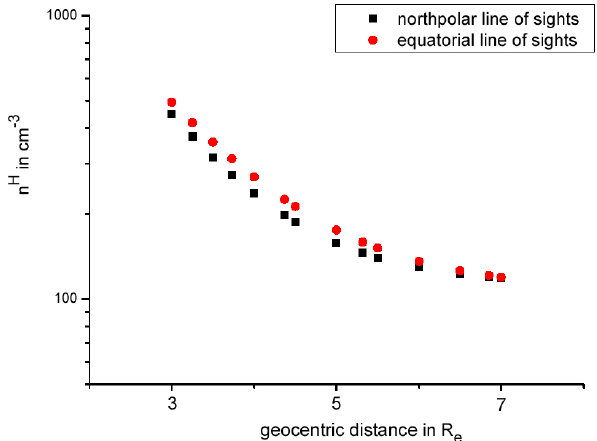
Fig. 5. Separately fitted H-density profiles (11 June 2008) for lines of sight with earth passing point in the north pole region (black) and in the equatorial region (red), respectively. The equatorial H-density profile is only slightly higher then the polar profile, that points to a weak pole/equator